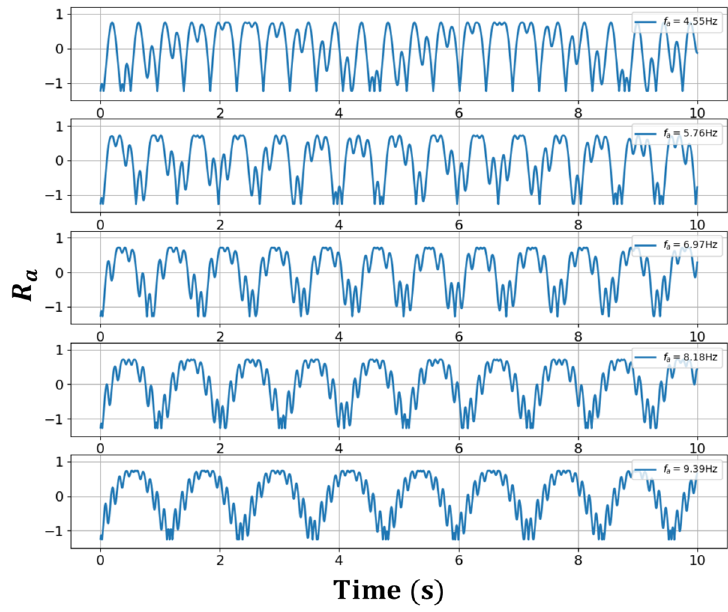
Figure 3. R a outside the lock-in area. Figure 3. 𝑹 𝒂 outside the lock-in area. Figure 3. 𝑹 𝒂 outside the lock-in area.